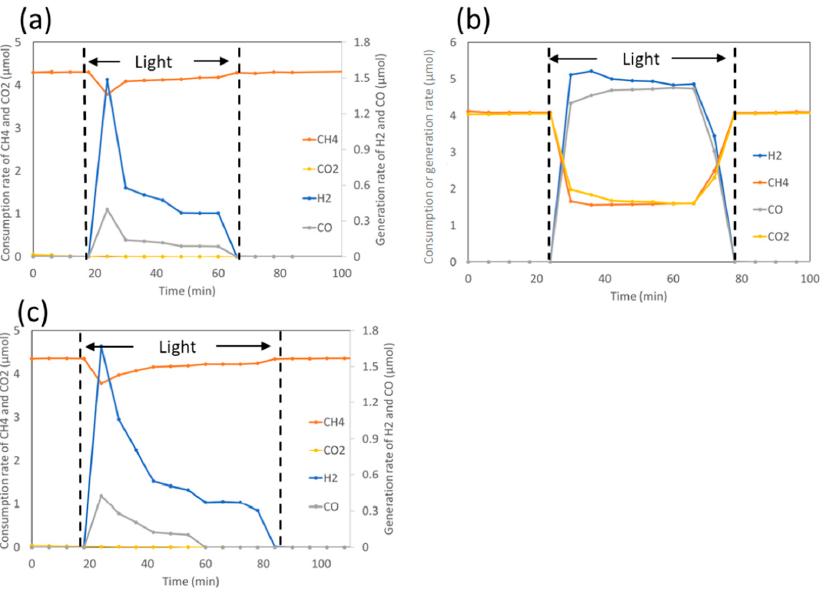
Figure 34. Sole gas experiment performed using Rh/SrTiO 3 . First, ( a ) methane only; then, ( b ) a mixture of methane and carbon dioxide; finally, ( c ) methane again. Reprinted from [30].